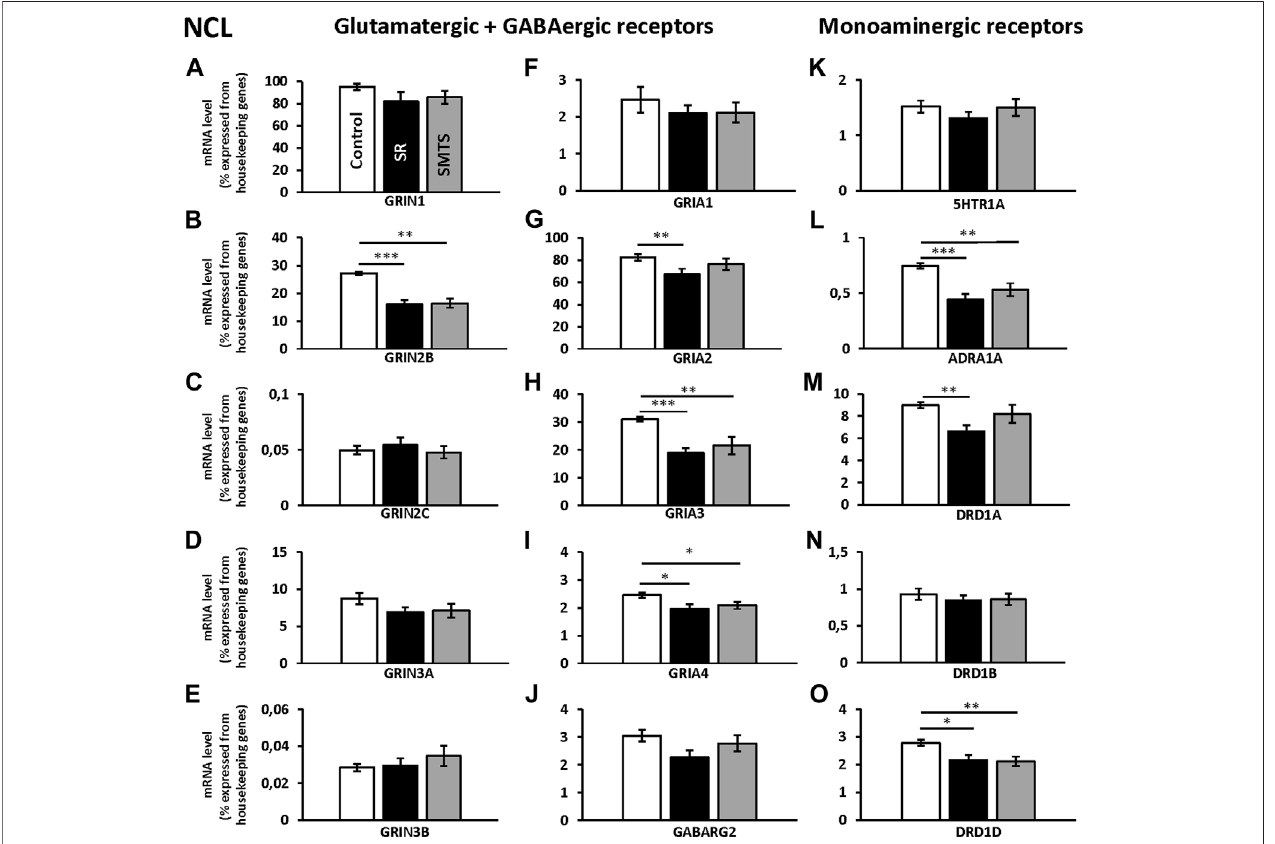
FIGURE 4 | Neurotransmitter receptor expression in the nidopallium caudolaterale (NCL) after learning different tasks. The mRNA levels of 15 neurotransmitter receptors andsubunitswerequanti fi ed asrelative expression levels inpercent expressed ofthetwohousekeepinggenes H3-3B and GAPDH .Resultsforglutamatergic and GABAergic receptor mRNA levels in the control group (Control, white), the stimulus-response group (SR, black) and the simultaneous-matching-to-sample group (SMTS, grey)are presented in (A – J) and monoaminergic receptor mRNA levels in (K – O) (mean ±SEM; N=10 foreach group). Signi fi cantdifferences between the different learning groups are highlighted with asterisks ( p p < 0.03; pp p < 0.01; ppp p < 0.001).